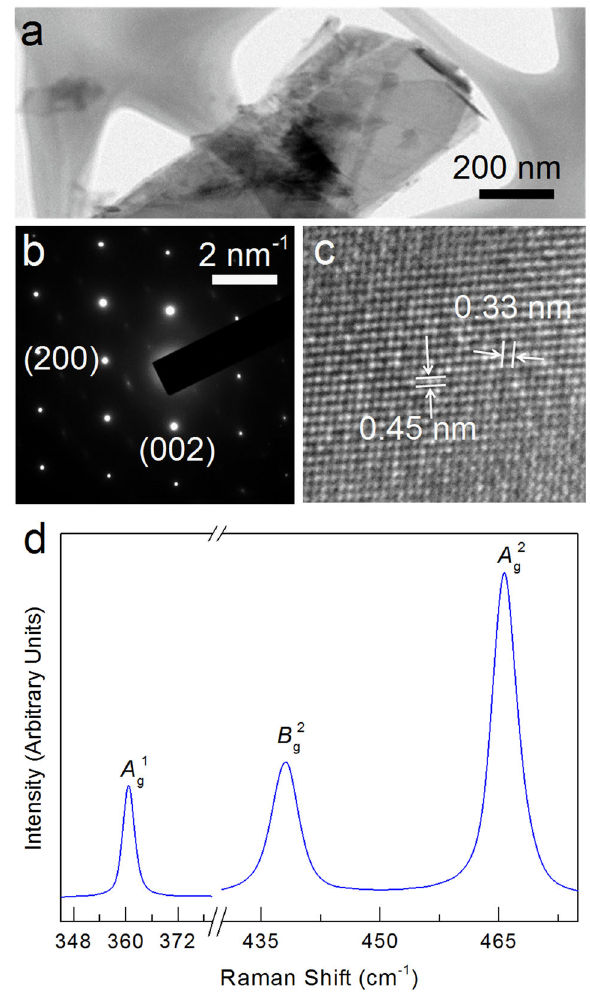
Fig. 1 Characterisation of mechanically-exfoliated black phos- phorus. a Transmission electron micrograph of a multilayer BP fl ake. b SAED pattern and c HRTEM image of the crystal shown in a , indicating the presence of crystalline BP. d Micro-Raman spectra of a BP fl ake showing the presence of all three signature BP